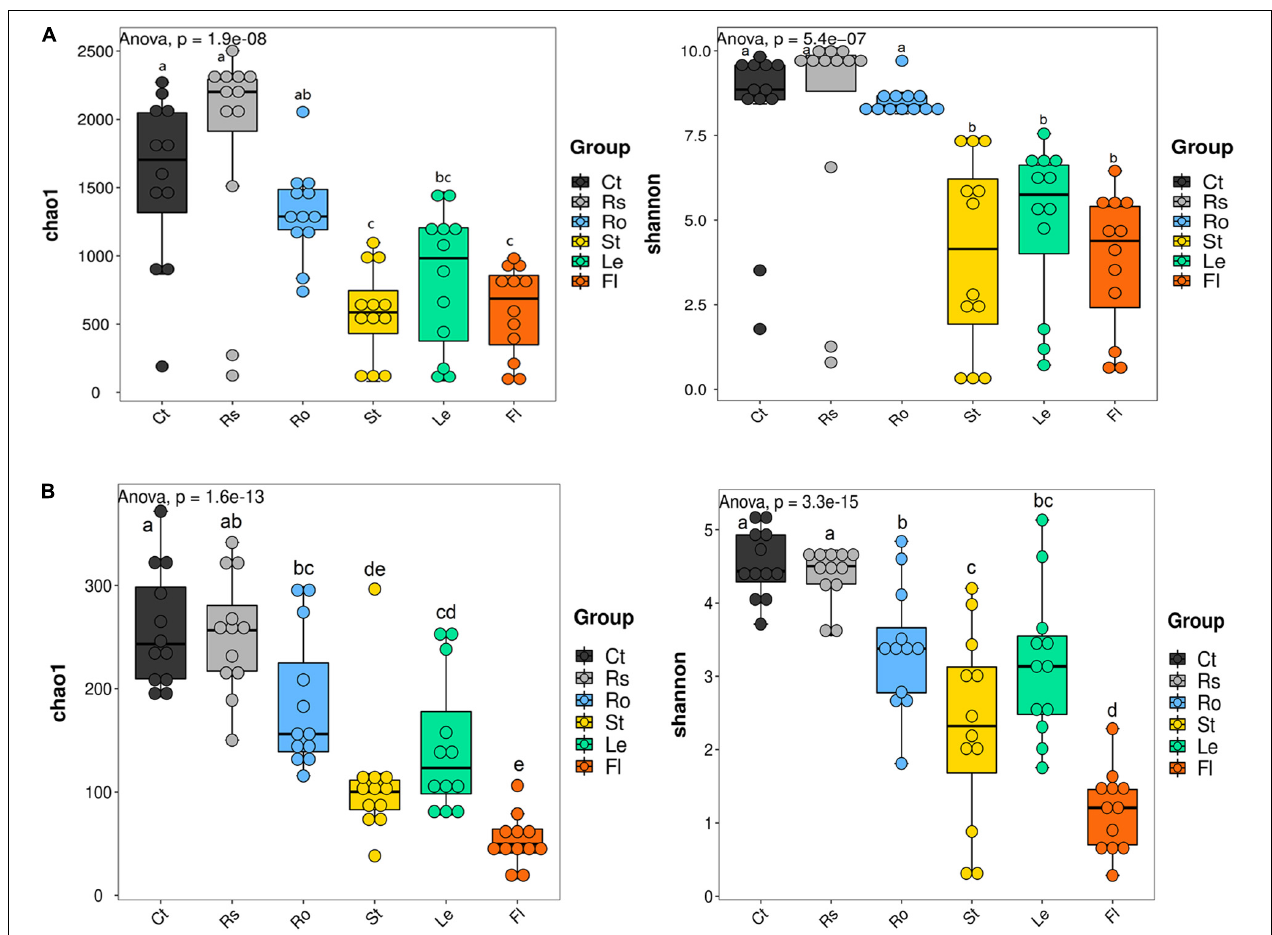
FIGURE 2 | Alpha diversity of microbial communities associated with hemp plants. (A) Bacteria. (B) Fungi. Ct, Rs, Ro, St, Le, and Fl represent bulk soil, rhizosphere soil, root endosphere, stem endosphere, leaf endosphere, and flower endosphere,